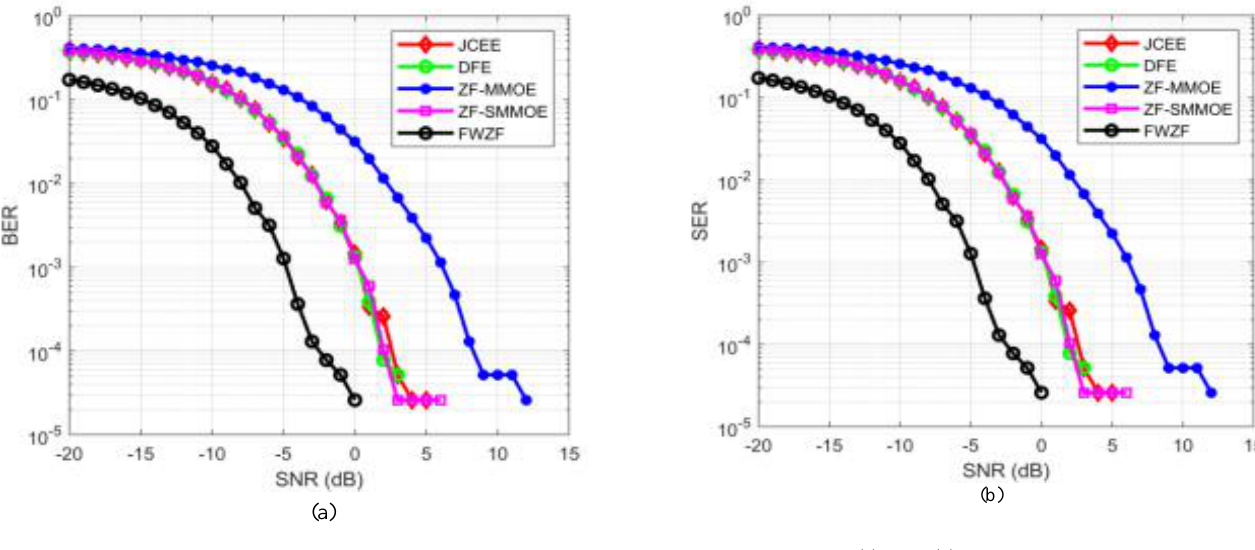
Fig. 2. Comparative analysis using antenna=4 in Rayleigh channel, (a) BER, (b) SER